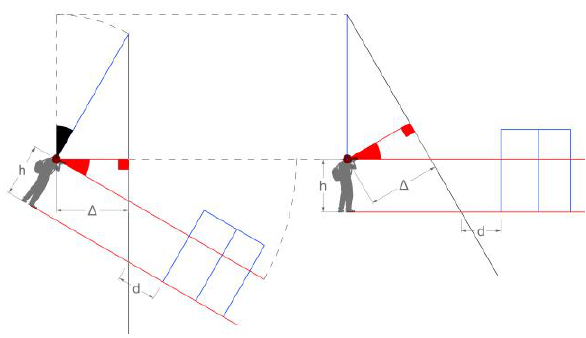
Figure 6 . Rotation of the perspective layout. The width of the façade of Santa Maria della Scala was recovered by a period drawing and was compared with the width and height of the portal at the Regional Museum and with a map of Messina before the earthquake (fig. 7).